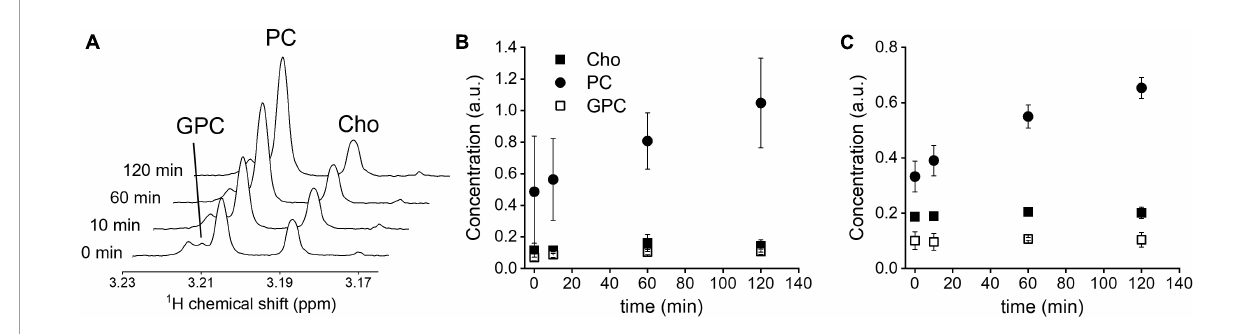
FIGURE1 In vitro Cho uptake. (A) 1 H NMR spectra of GL261 cell metabolite extracts at 0, 10, 60, and 120 min, zoomed in on the spectral region of the methyl group of choline-containing molecules. (B) Intracellular levels, normalized to creatine concentration, in RG2 cells ( n = 3), and (C) GL261 cells ( n = 3), during 120 min incubation with 1 mM unlabeled Cho. Cho, choline; PC, phosphocholine; GPC, glycerophosphocholine. Error bars = SD.